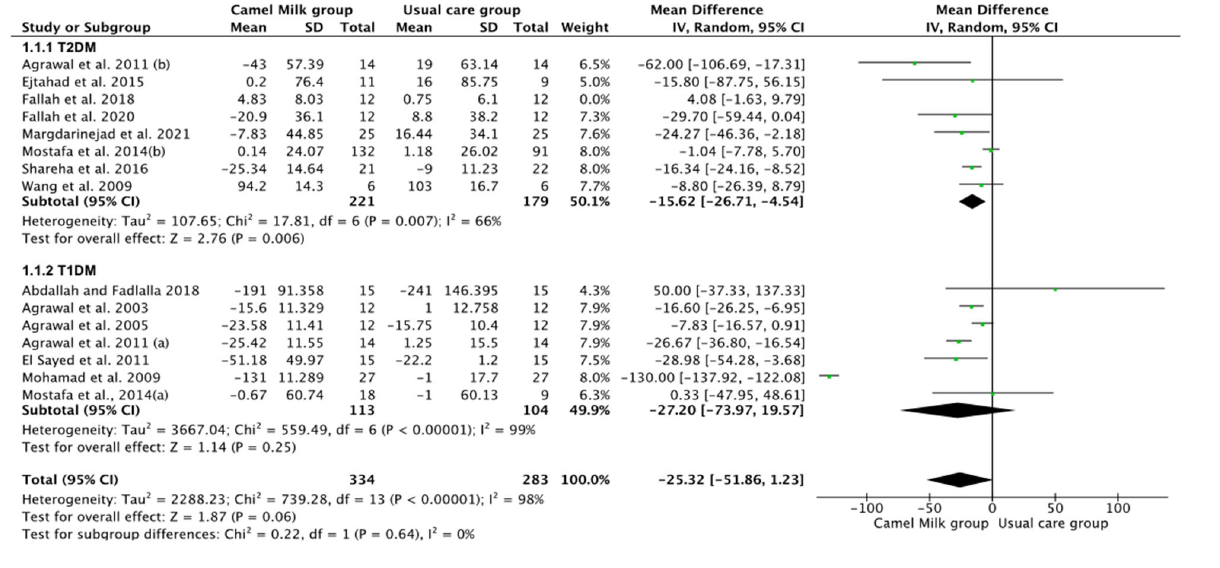
Figure 10. Forest plot for the effect of CM intake on FBG levels based on the type of diabetes. Note: Mostafa and Al ‐ Musa, 2014 (a) for T1DM and (b) for T2DM.